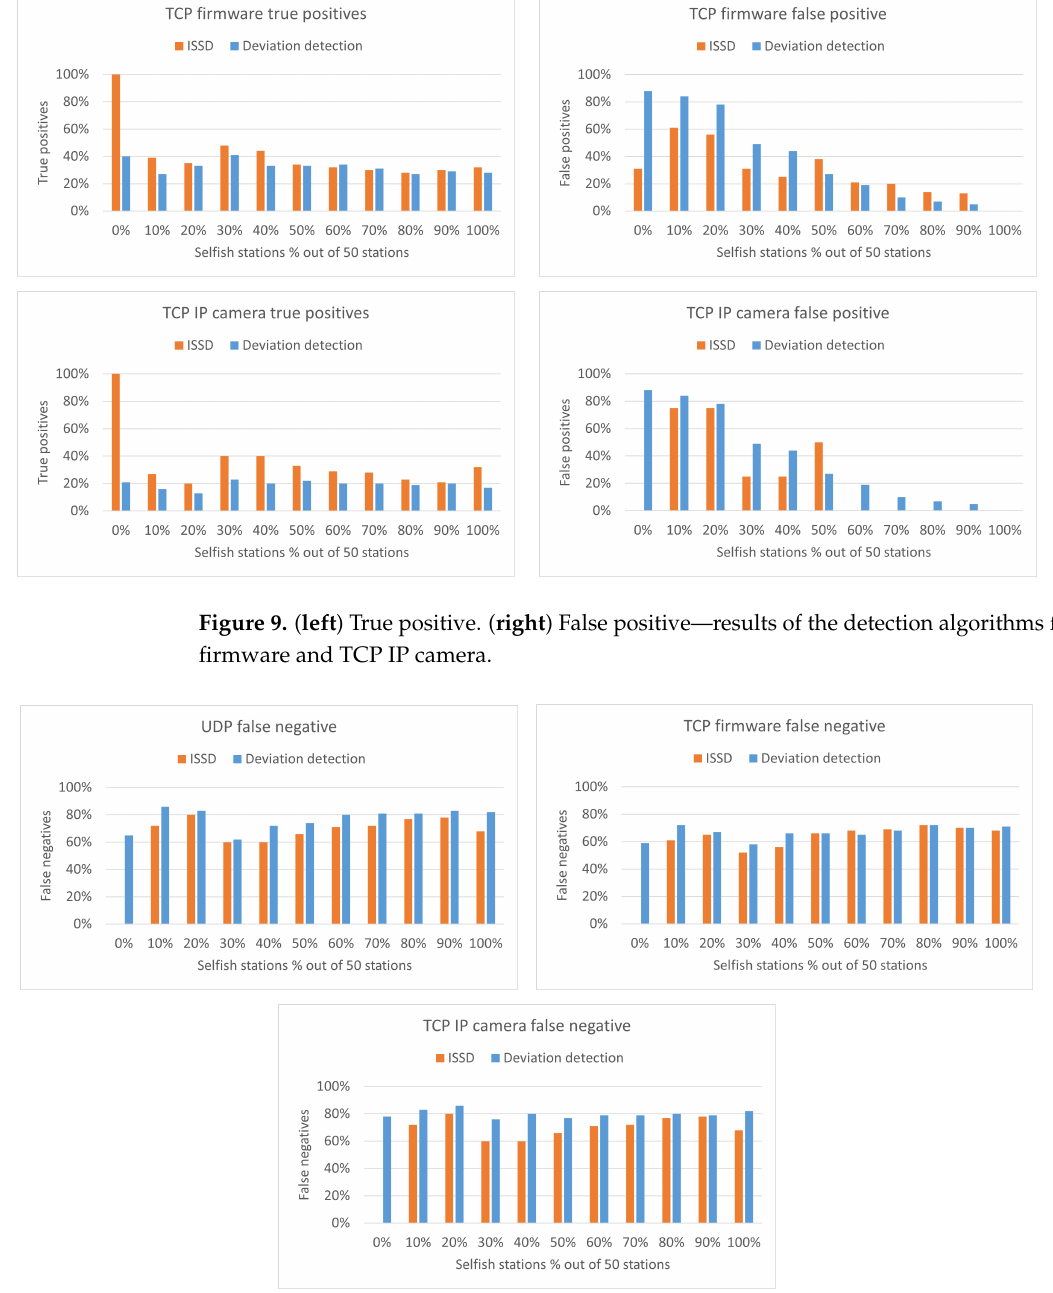
Figure 10. False negative results of the detection algorithms for UDP, TCP firmware and TCP IP